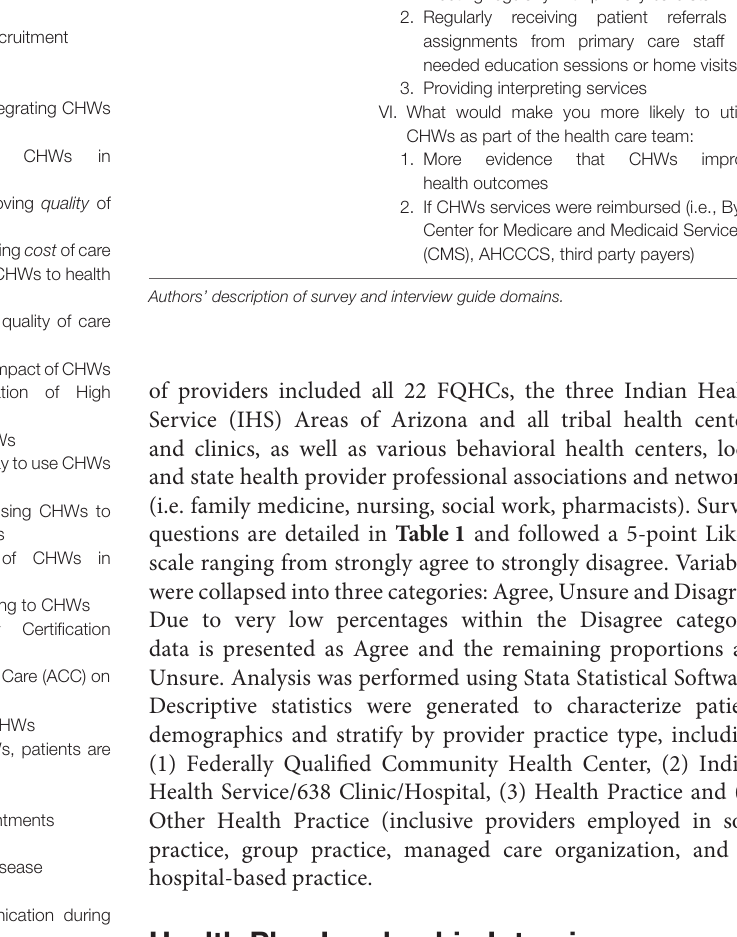
TABLE 1 | Health plan interview domain and licensed provider survey questions. Instrument Topic areas Health plan leadership interview guide ( N = 16) Semi-structured, qualitative small group phone interviews with 2-3 members of the health plan leadership